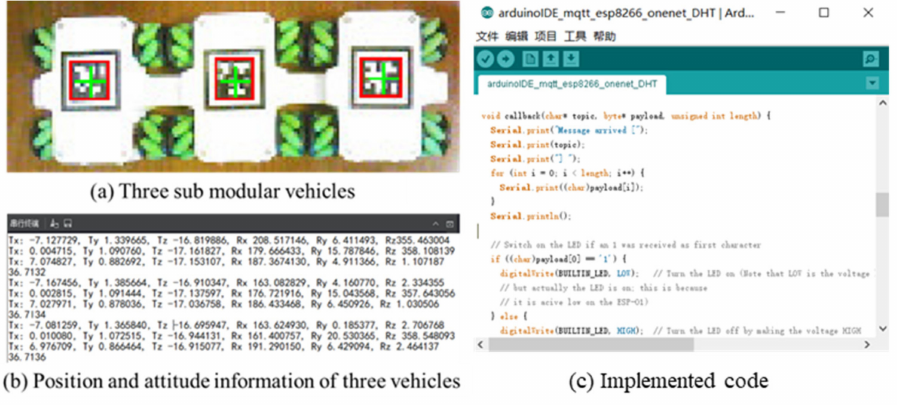
Figure 20. Position and attitude output of a modular